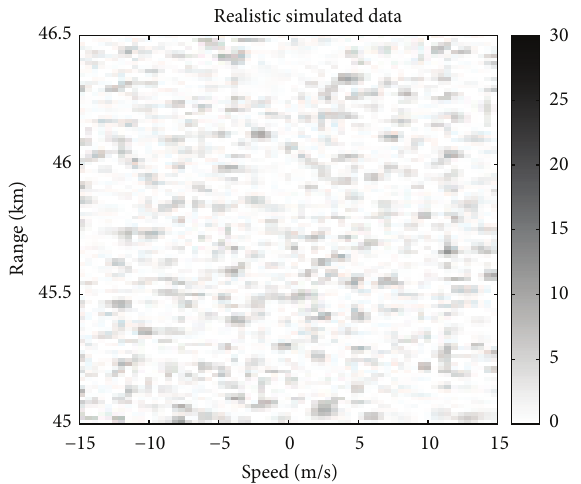
Figure 8: Range-Doppler map of the adaptive processing on realistic data.